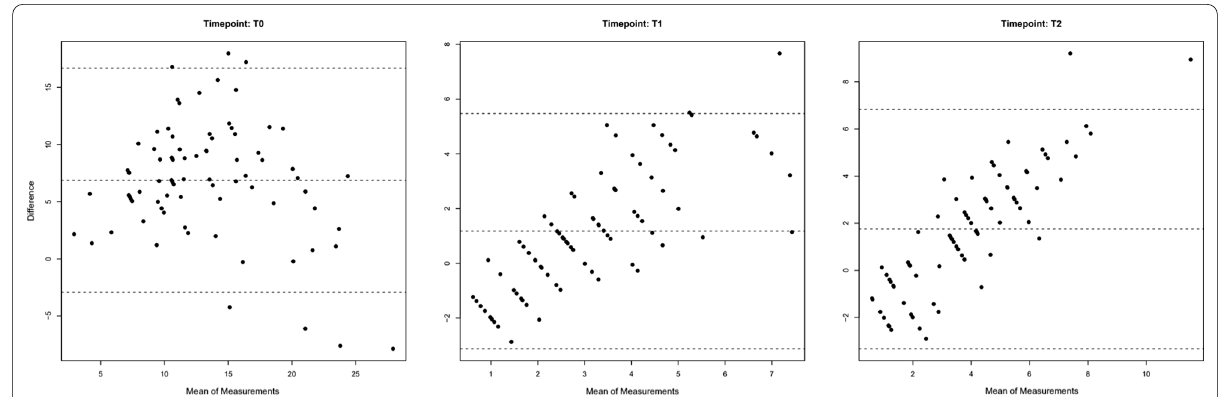
Fig. 1 Bland–Altman plots to compare the Orthodontic Alignment Index and Little’s Irregularity Index at T 0 (pre-treatment), T 1 (debond) and T 2 (12 months post-treatment)